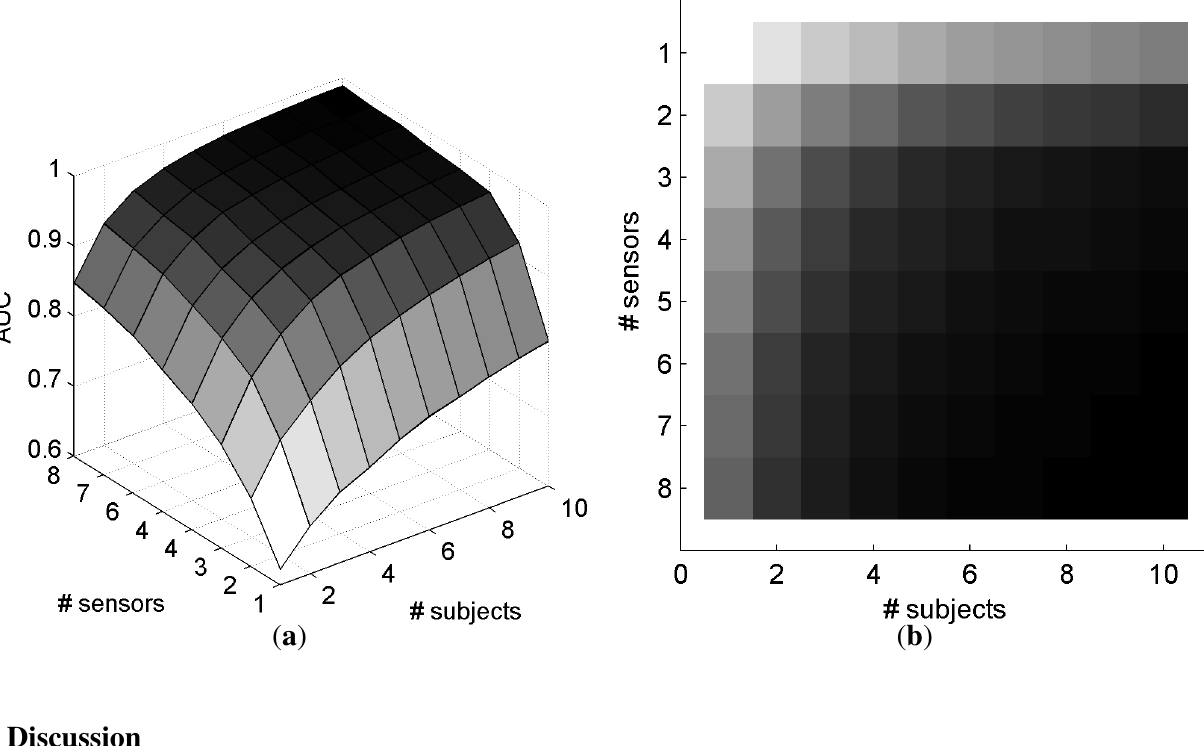
method individual